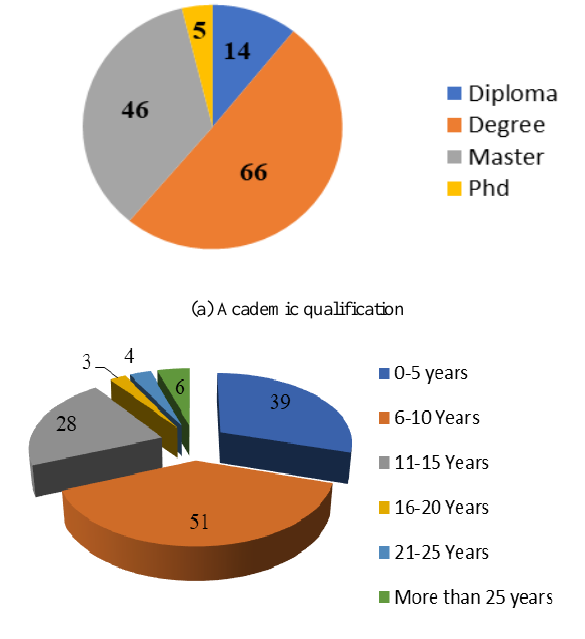
Fig. 2. Demographic information of the